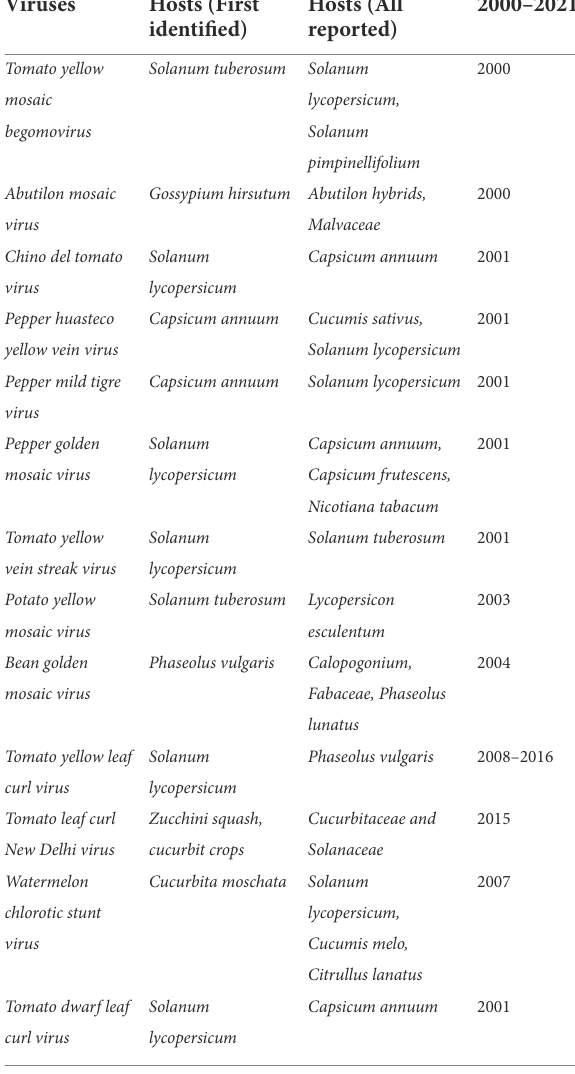
TABLE 3 EPPO alert list of important begomoviruses from 2000 to 2021. Viruses Hosts (First